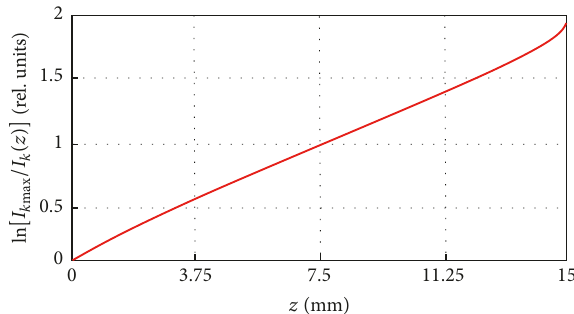
Figure 12: Graph of the attenuation of the collector’s current as the depth of the electron beam’s area of interaction with the walls of the penetration channel